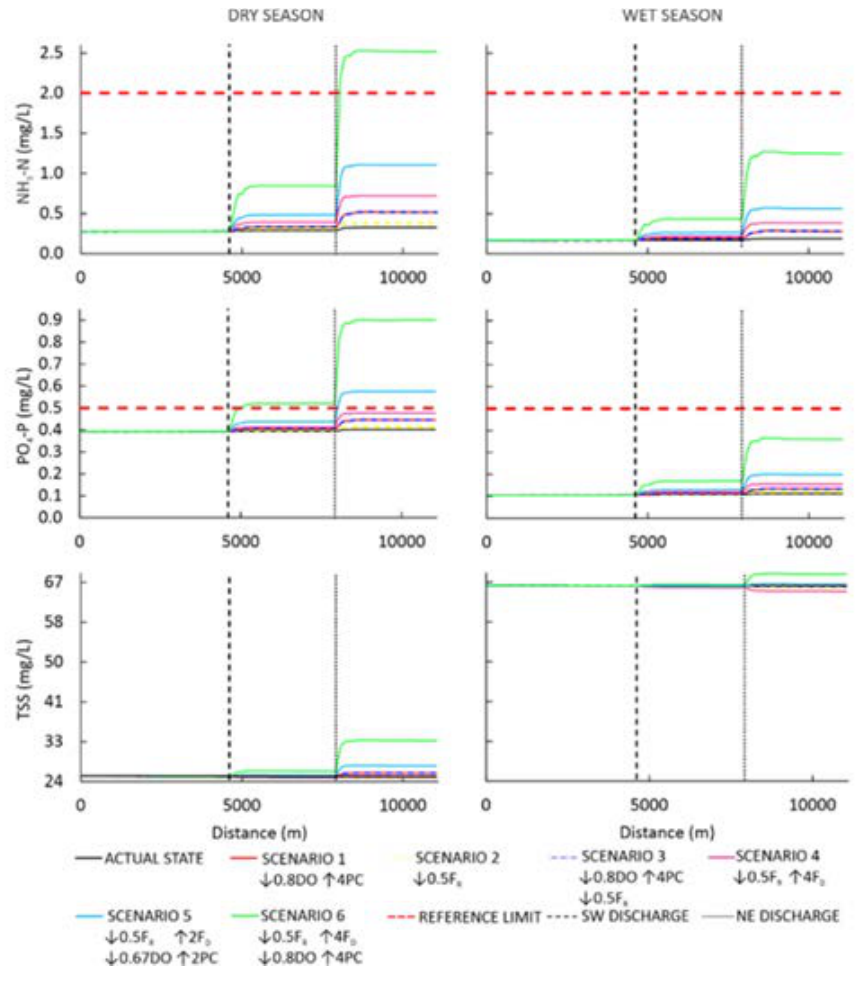
Fig. 10: Longitudinal profiles for PO 4 ‐P, NH 3 ‐N y TSS